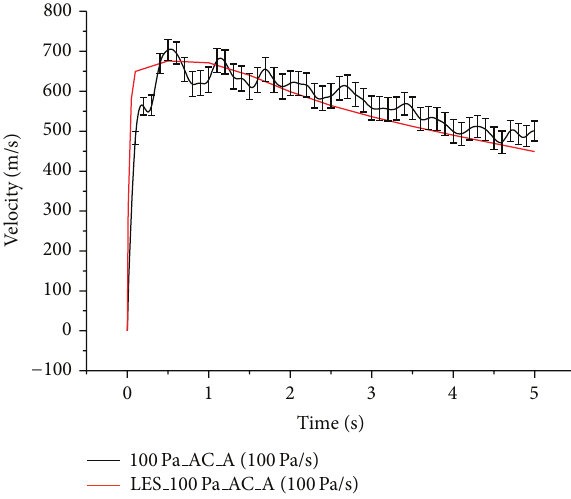
Figure 30: Velocity comparison at 100Pa/s. Figure 31: Velocity comparison at 300